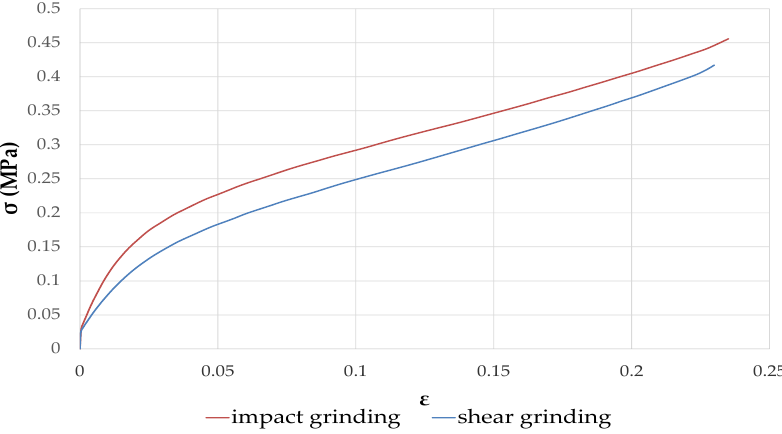
Figure 13. Compressive strength of BINP rapeseed concrete using two grinding techniques.